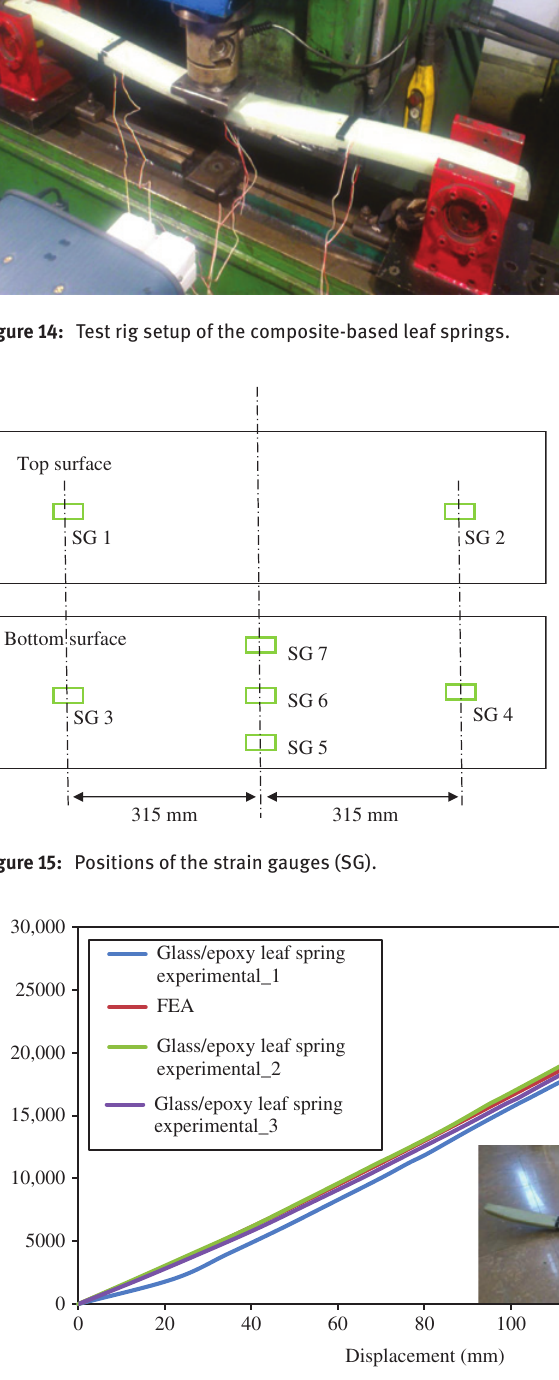
Figure 16: Predicted and experimental load-displacement response of Prototype